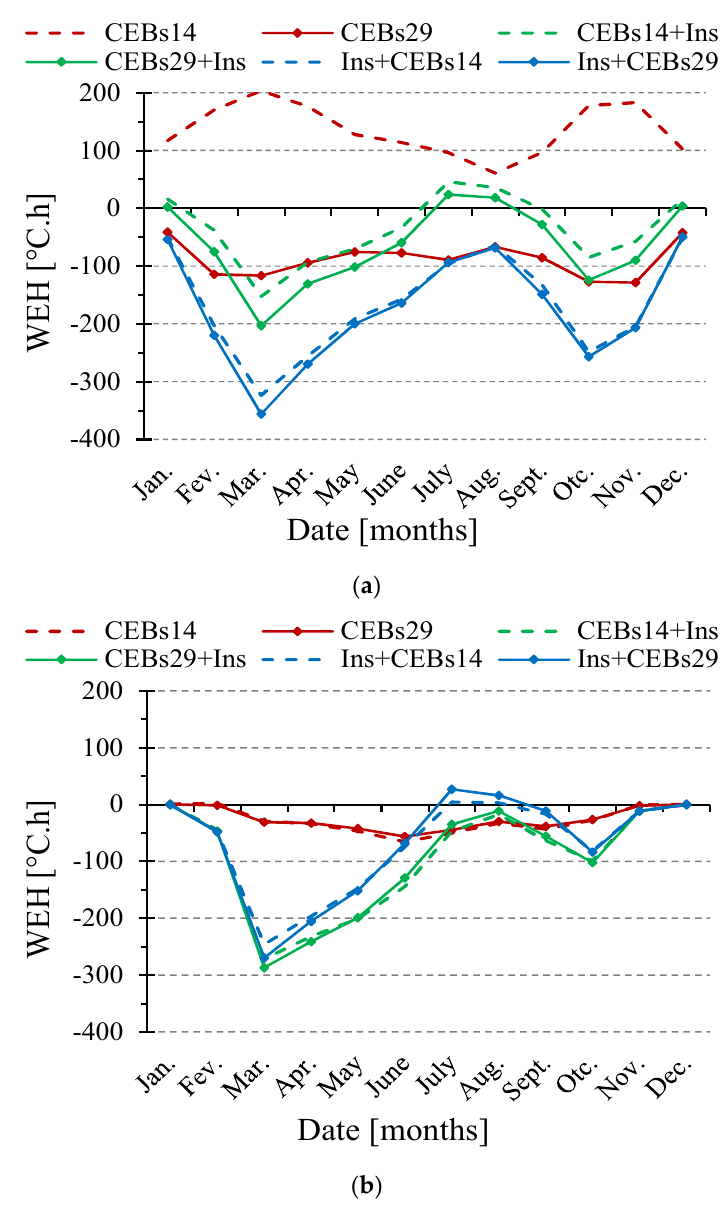
Figure 8. Profiles of thermal discomfort of 6 constructive systems compared to the building made of hollow concrete blocks (HCB) for ( a ) the living room and ( b ) the bedroom.